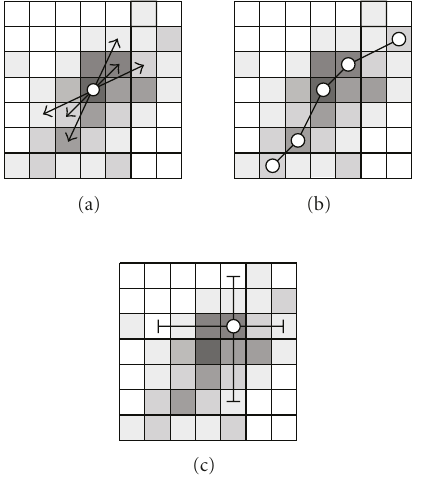
Figure 8: (a) Initial link and possible path extensions. (b) Path re- sulting from step (1). (c) Rays used for path removal in step (2).